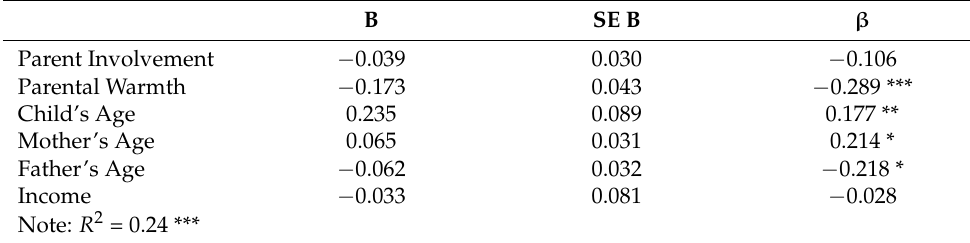
Table 11. Regression including demographic predictors—behavior